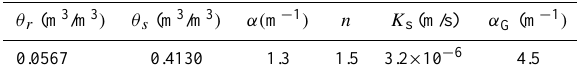
Table 4. Soil hydraulic properties for the van Genuchten-Mualem model estimated by ROSETTA code and Gardner’s α